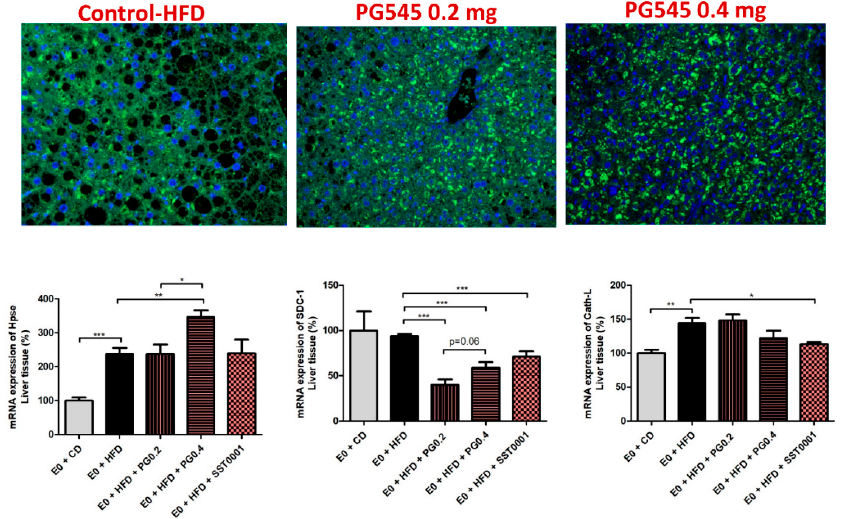
Figure 8. Effect of heparanase inhibtion on liver fibrosis. * p < 0.05, ** p < 0.01, *** p < 0.001 .